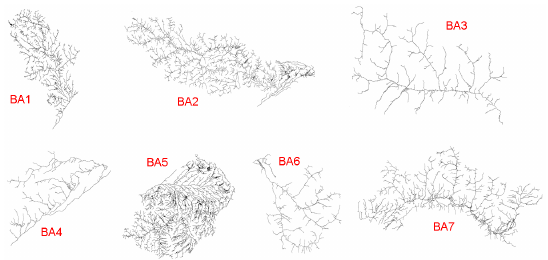
Figure A4. Drainage networks extracted from Baker